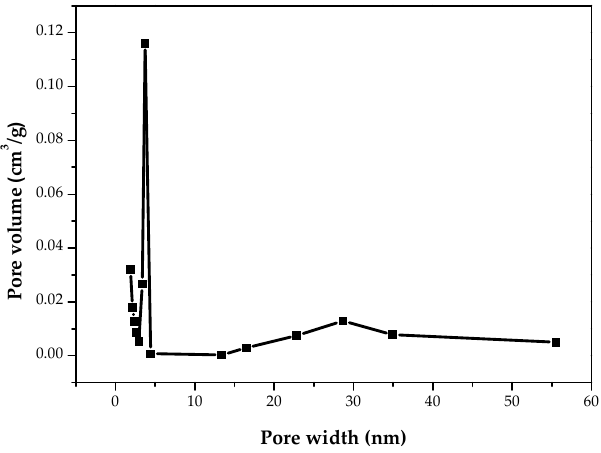
Figure 4. Pore size distribution curve of the biochar product (PP-BC-900-20).